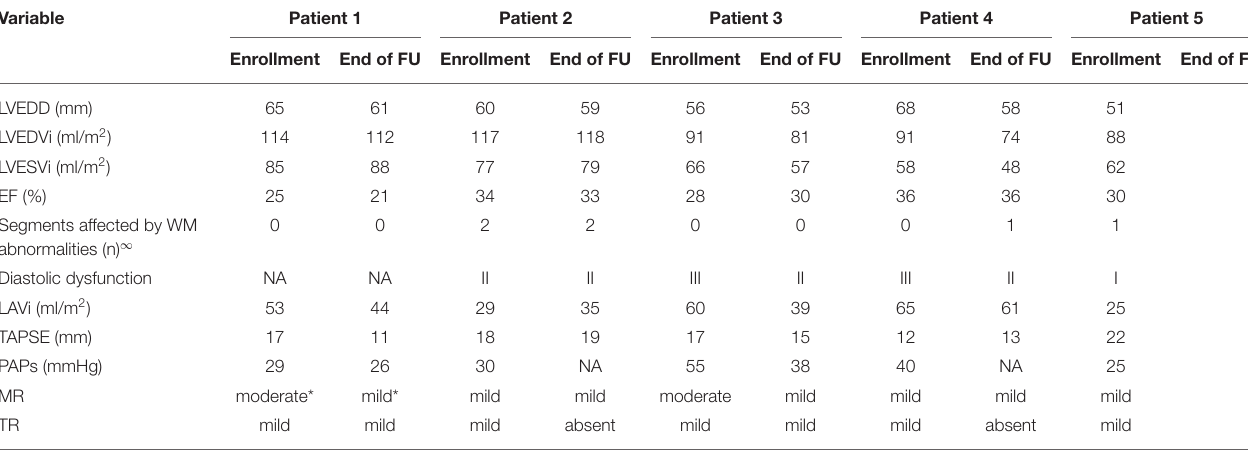
TABLE 2 | Echocardiographic features of the patients included.